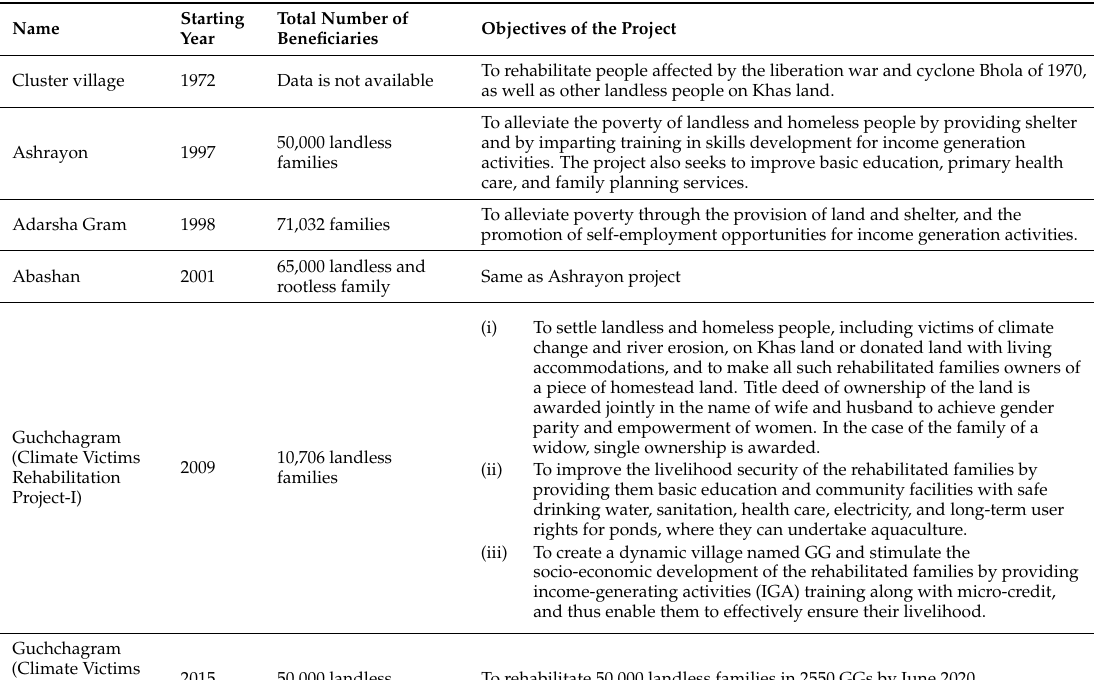
Table 1. Different resettlement and rehabilitation projects undertaken by the government since